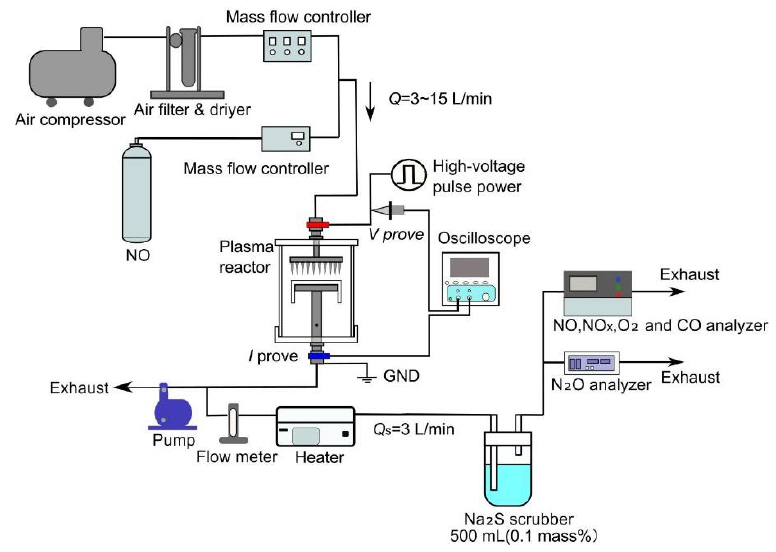
Figure 2. Schematic diagram of the experimental setup for direct plasma oxidation